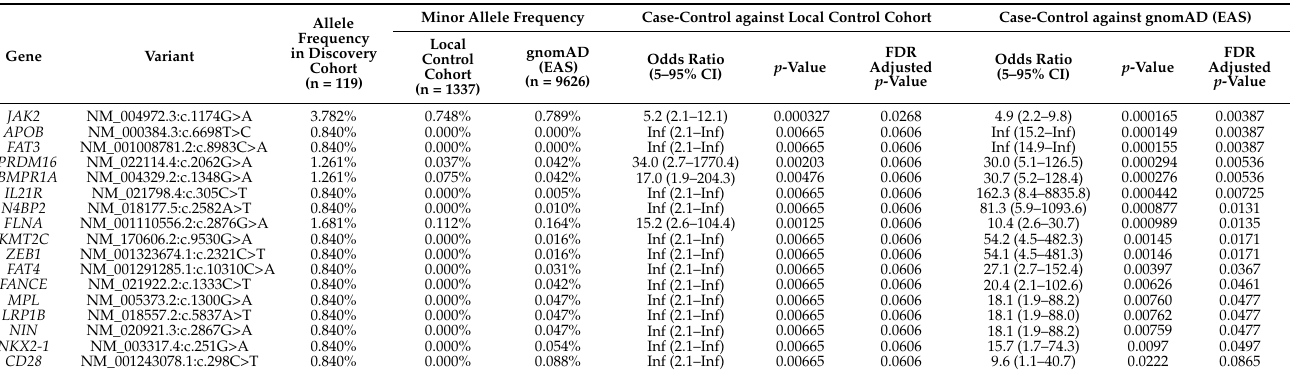
Table 1. Allele frequencies and case-control association analysis of 17 variants in 17 known or candidate cancer genes identified from the discovery cohort.